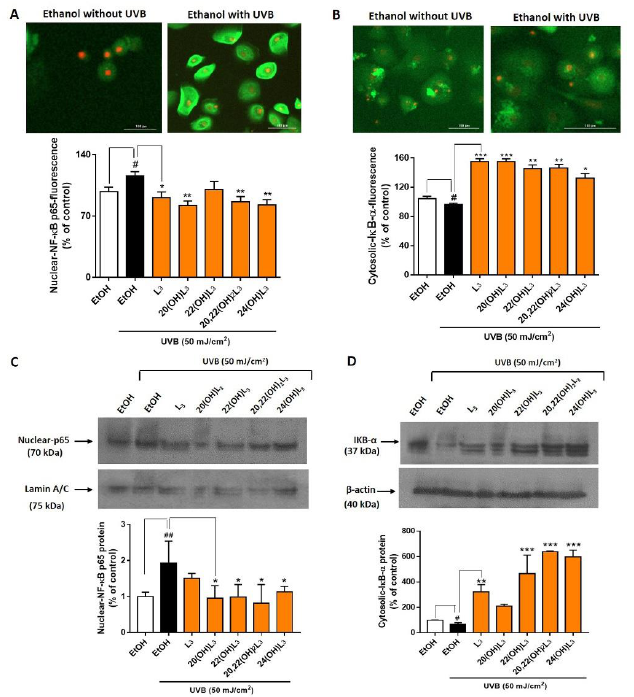
Figure 5. Lumisterol derivatives decrease nuclear NF- κ B p65 levels and increase cytosolic levels of I κ B- α in keratinocytes irradiated with UVB. Fluorescent microscopy of cells stained with ( A ) NF- κ B p65 and ( B ) I κ B- α antibodies were detected by the Cytation ™ 5 cell imaging, n ≥ 100 cells for each condition. Scale bar = 100 µ m. The single-color staining represents the expression in cytosol (green) and in nuclei (red), whereas the dual expression (orange–yellow) represents the expression in both cytosol and nucleus. Data are presented as the % of control for the nuclear-NF- κ B p65 and the cytosolic-I κ B- α (mean ± SD). ( C ) Western blot analysis of nuclear-NF- κ B p65 (70 kDa) and ( D ) cytosolic-I κ B- α (37 kDa). Data were normalized with lamin A / C (nuclear protein) and β -actin (cytosolic protein) and are presented as % of control for nuclear-NF- κ B p65 or cytosolic-I κ B- α expression (mean ± SD, n = 3). The statistical significance of di ff erences between the non-irradiated control (white bar) and UVB-irradiated cells (black bar) was evaluated by Student’s t -test, and between UVB-irradiated controls and cells treated with lumisterols (dark orange bars) by one-way ANOVA with Dunnett’s multiple comparison test. # p < 0.05, ## p < 0.01 versus non-irradiated control cells. * p < 0.05, ** p < 0.01, and *** p < 0.001 versus untreated cells exposed to